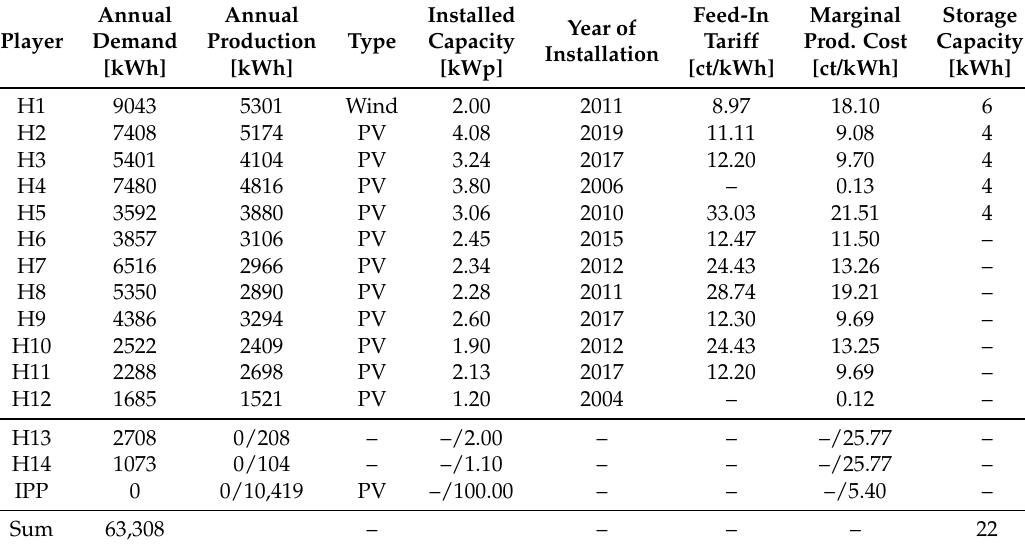
Table A1. Data for each household in the model